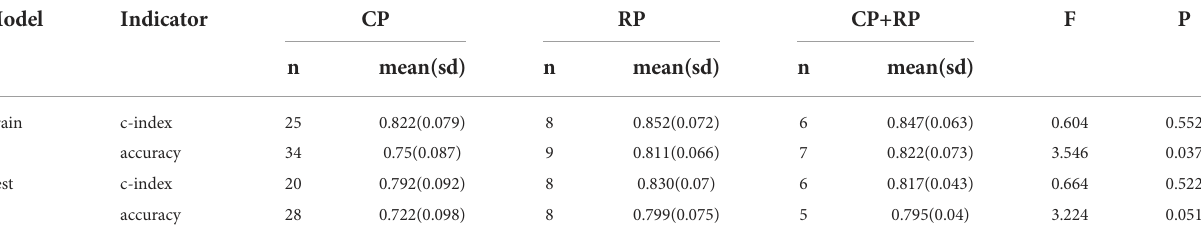
TABLE 6 Subgroup analysis for